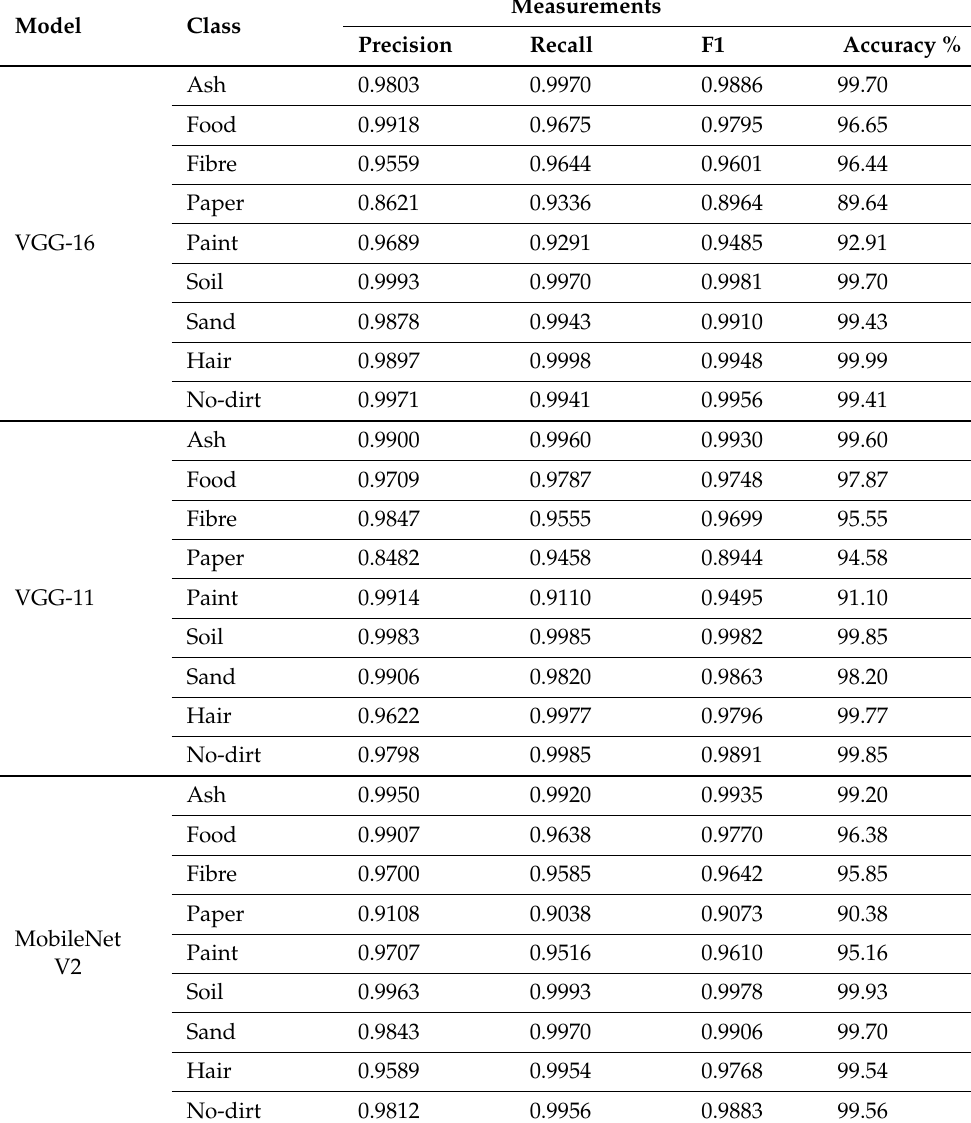
Table 3. Statistical measures for dirt